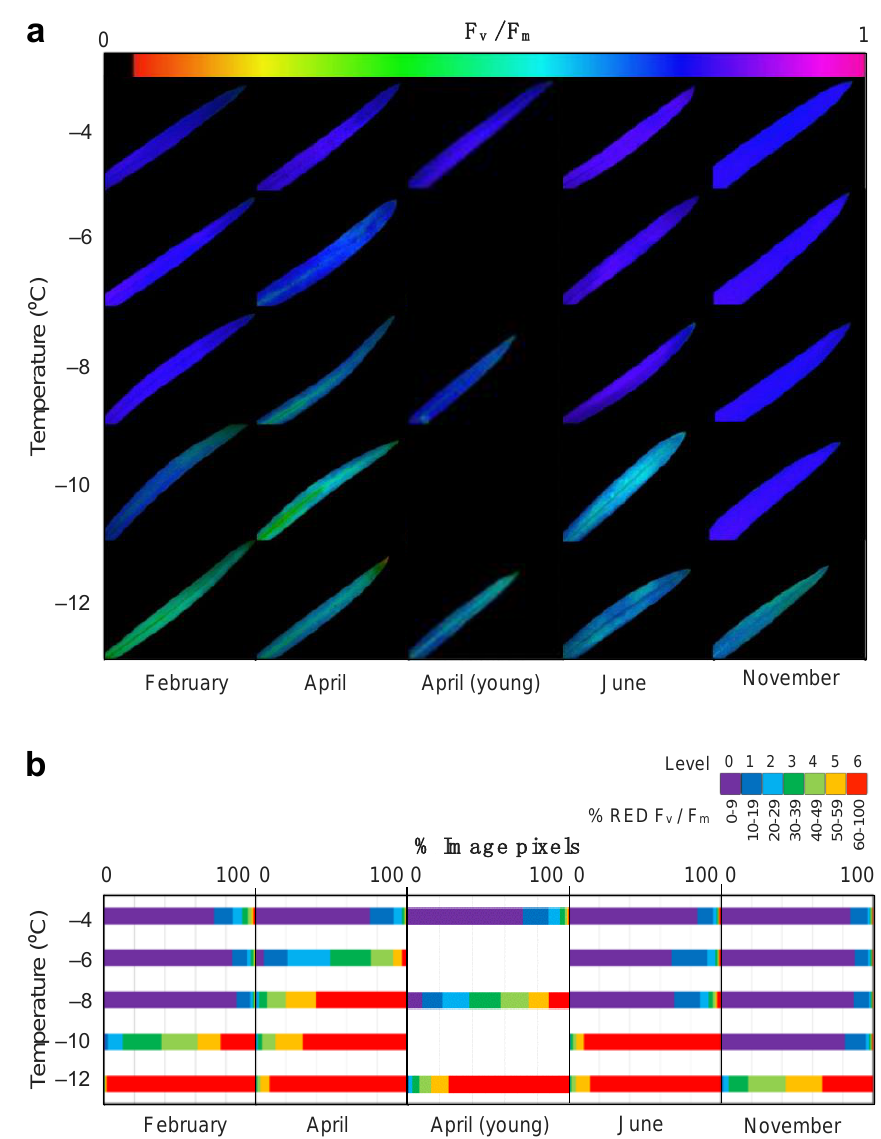
Figure 2. Effect of low temperature treatment on E. scoparium leaves as obtained from chlorophyll fluorescence imaging analysis. ( a ) Representative images of chlorophyll fluorescence showing F v /F m values of whole leaves after selected temperature treatments. ( b ) Summary of the quantitative analyses of F v /F m images. The % of reduction in the F v /F m was classified in seven stress levels as shown in the legend (violet: Low to non-reduction, red: Dramatic reduction). The length of the horizontal colour bars is proportional to the number of image pixels of each